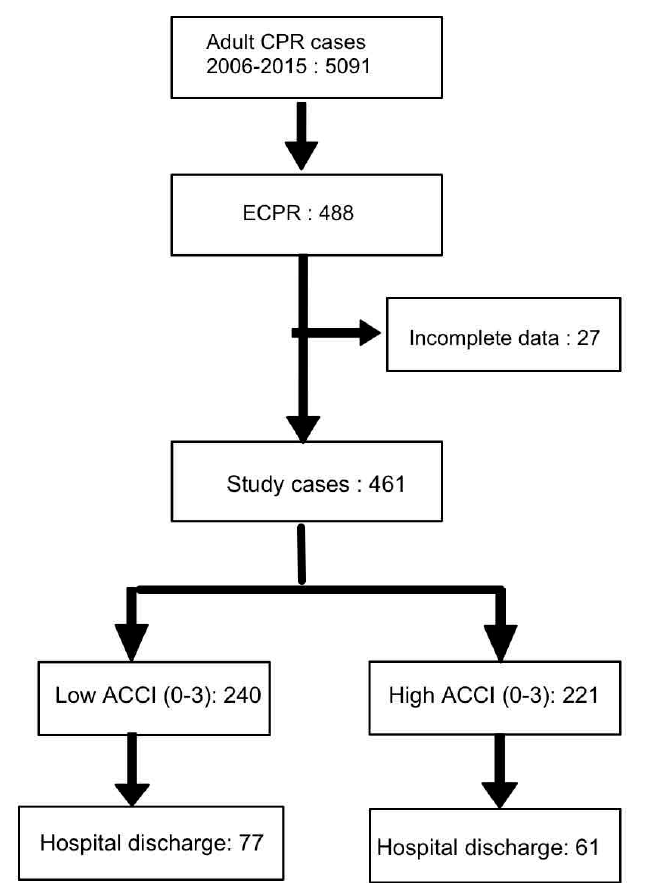
Figure 1. Flowchart of study patients. CPR: cardiopulmonary resuscitation; ECPR: extracorporeal cardiopulmonary resuscitation; ACCI: age-adjusted Charlson comorbidity index.